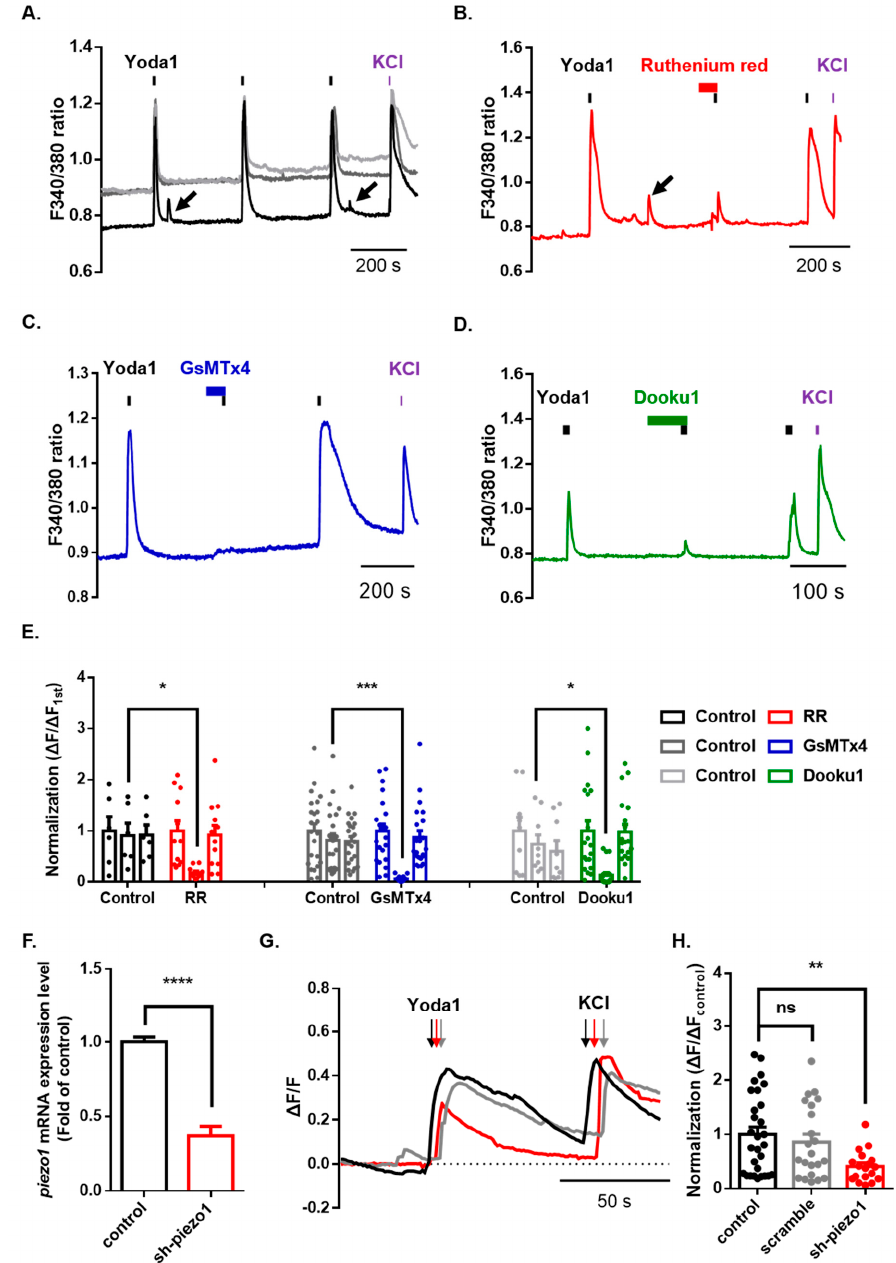
Figure 3. Inhibition of Piezo1 by mechanical-ion channel inhibitors and short hairpin RNA-mediated silencing of Piezo1. ( A ) The Yoda1 (10 μ M, 10 s)-induced intracellular Ca 2+ increase. The Yoda1 (10 μ M, 10 s)-induced intracellular Ca 2+ increase is reversibly inhibited by ruthenium red (30 μ M, N and P-type nonselective Ca 2+ channel blocker, red) ( B ), GsMTx4 (2.5 μ M, selective stretch-activated